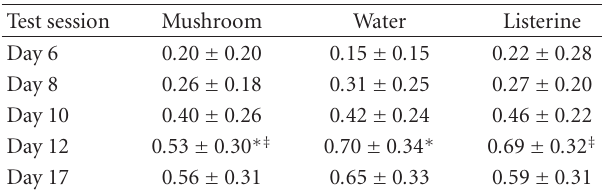
Table 2: Cumulative gingival index scores ( ± standard deviation) at the various test sessions during the treatment of volunteers with three di ff erent mouthwashes. Statistically significant di ff erences ( P < 0 . 05) are marked by ∗ or ‡